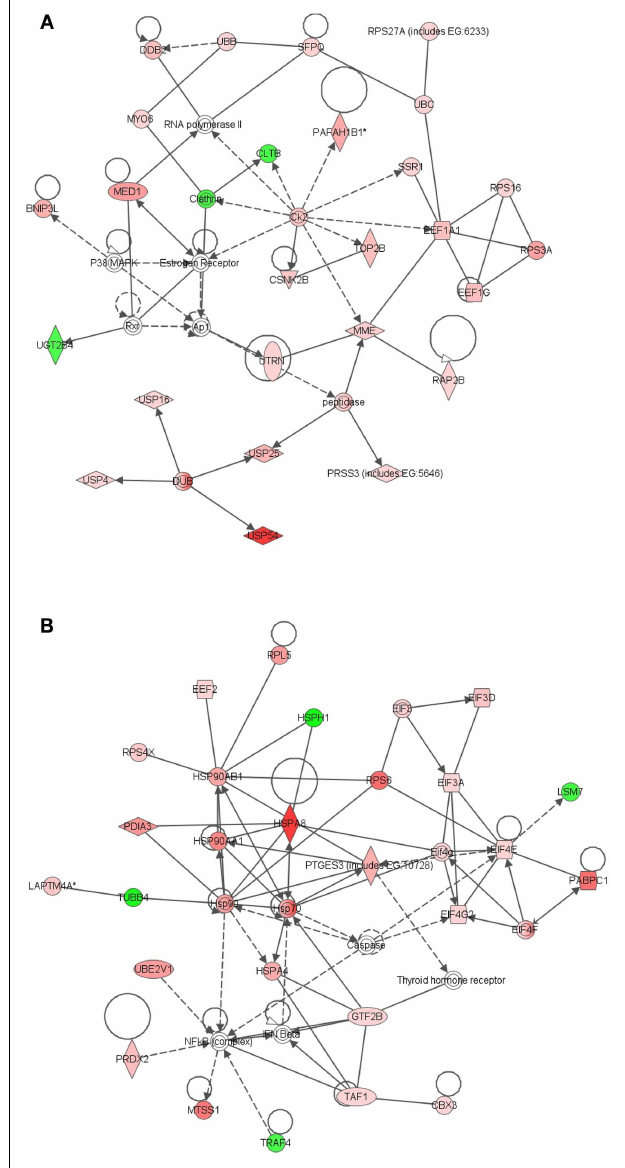
FIGURE 4 | Ingenuity PathwayAnalysis (IPA) of genes differentially expressed in LRECb vs. LRECe. Genes that were differentially expressed in LRECb vs. LRECe were imported into IPA software, which revealed the involvement of several networks pertinent to LRECb. Network (A) pertains to tissue development, cell growth and proliferation. Network (B) is associated with tissue injury and contains a heat shock protein module that was up-regulated in LRECb. Red color denotes up-regulation in LRECb and green color denotes down-regulation in LRECb relative to control cells.The IPA legend is shown in FigureA1 in Appendix.